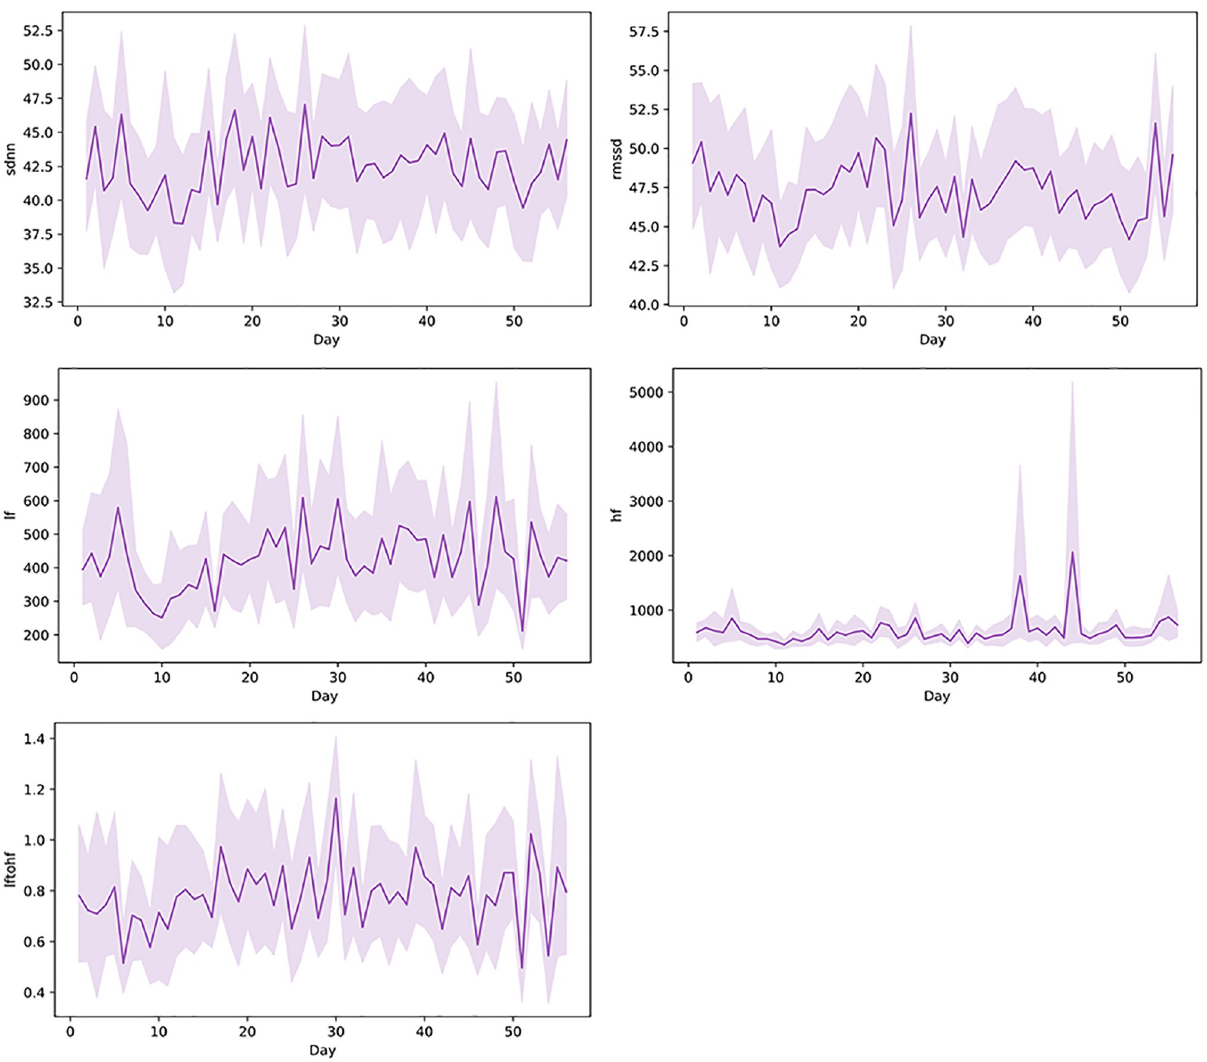
Fig 2. Trends in HRV parameters. The mean daily values with 95% confidence intervals of SDNN, RMSSD, LF, HF and LF/HF ratio during the eight- week data collection period (56 days) (n =